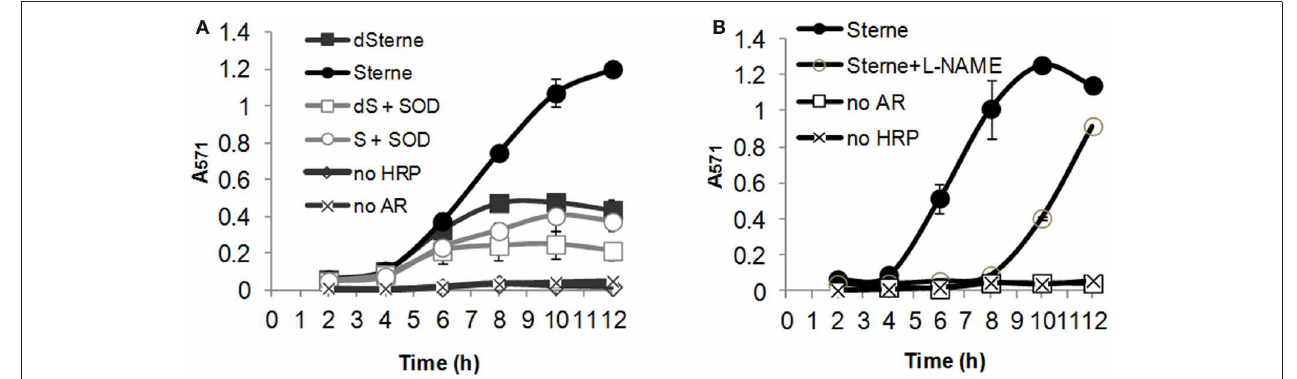
FIGURE 6 | SOD and L-NAME but not catalase inhibit oxidation of AR during bacterial growth in microaerobic conditions. (A) Effect of SOD and catalase. In the presence of catalase (20 μ g/ml) the response is indistinguishable from that of Sterne strain only. (B) Effect of L-NAME. Sups were prepared by growing bacteria in static conditions at 37 ◦ C, 5% CO 2 in 24-well plate containing 1.5ml of DMEM/F-12 medium per well (A) or 12-well plate containing 5ml of DMEM/F12 medium per